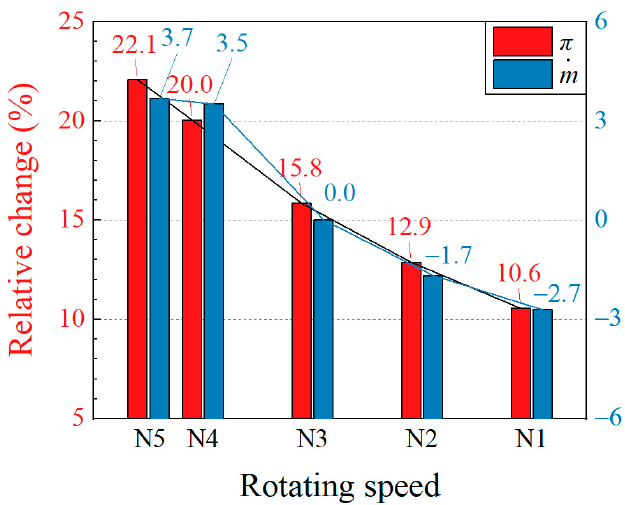
Figure 24. Gain of π and . m choke choke at different rotating speeds. The booster rotor was introduced to increase the core pressure ratio. Since the tan- gential velocity near the hub of the rotor domain is insufficient, the tandem rotor implants energy into the airflow by increasing the flow turning, thereby enhancing the compression intensity of the airflow before the aerodynamic throat. During the aerodynamic design, to improve the compression capability near the hub, the total camber angle of the tandem rotor (53 ◦ ) is much larger than that of the baseline fan rotor (33 ◦ ). Therefore, the reaction near the tandem rotor hub is reduced compared to that at the baseline fan rotor, and the airflow velocity at the stator inlet accordingly increases. The stator inflow can even reach the supersonic condition at N4 and N5. Therefore, a great negative incidence under choke condition was designed to avoid premature corner stall. In contrast to the subsonic inflow in the Laval nozzle, the determination of the aerodynamic throat position under such inflow condition is rarely studied; thus, physical modeling analysis is required. Figure 25 presents a schematic to analyze the aerodynamic throat position. The green lines in the figure represent the detached shock wave, and the red and blue dashed lines represent the expansion waves emitted by the suction surface (SS) and PS, respectively. An expansion wave from PS will first intersect with the LE of the stator. Although the disturbance after the expansion wave cannot affect the flow field in front of the blade, the disturbance from SS can still be transmitted upstream. Therefore, when an expansion wave emitted from SS intersects the LE of the adjacent blade, the flow field in the channel will no longer affect the upstream. Then, the position of the aerodynamic throat can be determined. However, the two expansion waves from SS and PS will intersect with a high probability. Thus, the lower half of the throat profile is determined by the expansion wave from SS, while the upper half is determined by the expansion wave from